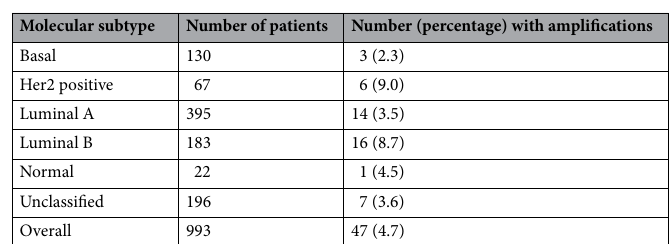
Table 4. Amplifications in RHOD in The Cancer Genome Atlas according to molecular subtype.